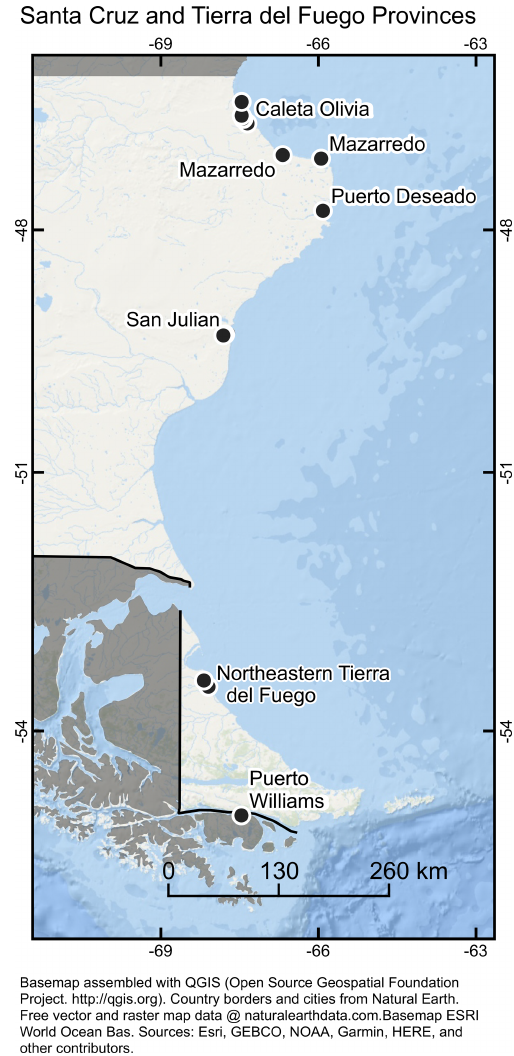
Figure 9. MIS 5 sea-level indicators in Santa Cruz Province, Ar- gentina, and Tierra del Fuego (Argentina and Chile) (black